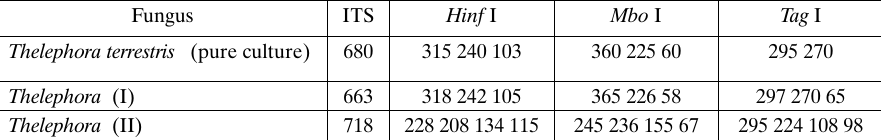
Approximate restriction fragment sizes (bp) of the amplified fungal ITS region of T. terrestris mycorrhizas